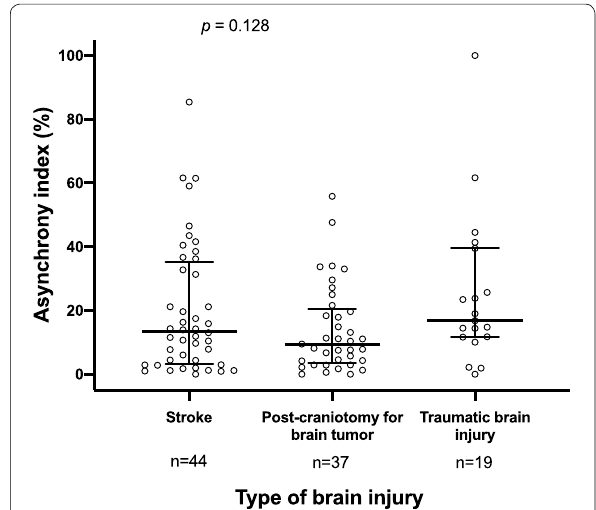
0.128). Individual =